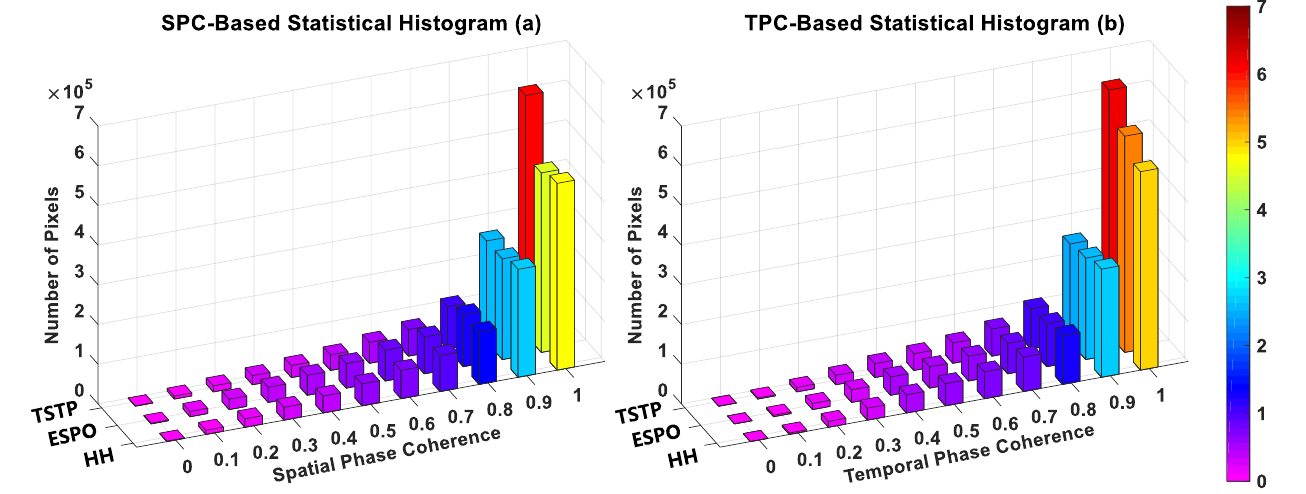
Figure 7. Estimated coherence histograms of the full scene under different methods (i.e., HH, ESPO, and proposed TSTP). ( a ) SPC. ( b ) TPC. Under the premise of the same number of candidate pixels, highly coherent pixels increases, and accordingly the number of the lowly coherent pixels